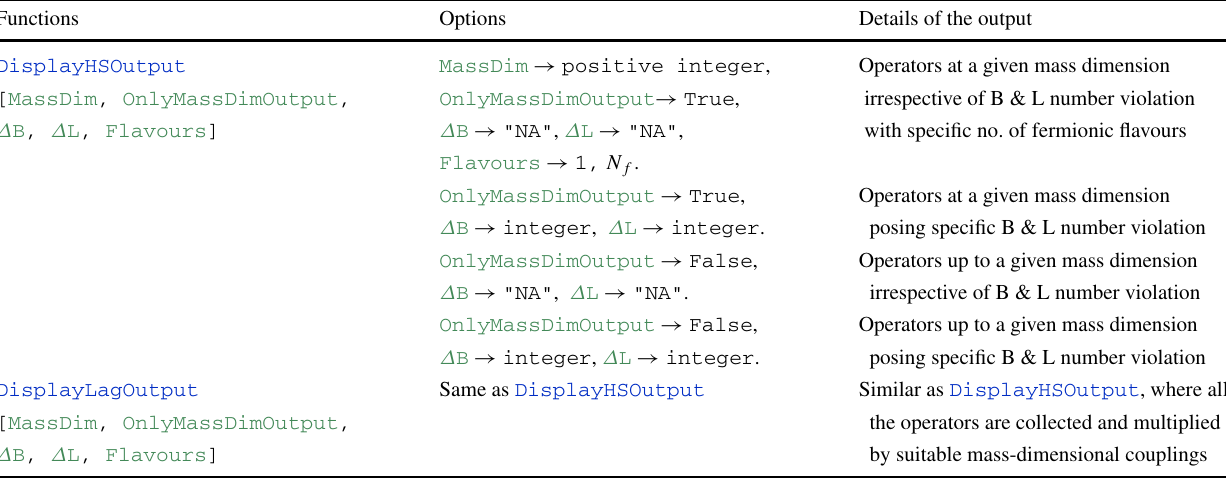
Table 13 GrIP functions and their working